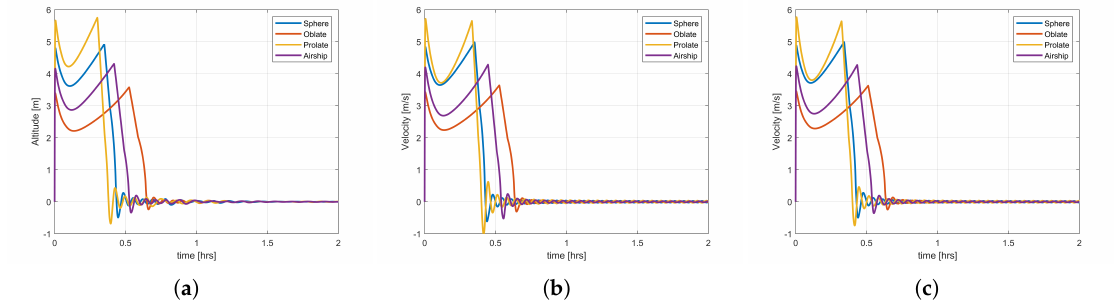
Figure 9. Ascent speed variation of different balloon types at particular fineness ratio ( a ) Zero pressure ( b ) Super pressure ( c ) Over-pressurized zero pressure. A fineness ratio of 3 is chosen for oblate shape, 0.6 for prolate shape, and 0.4 for airship